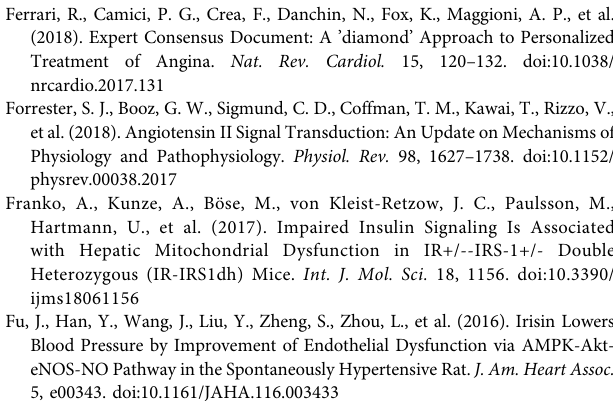
Supplementary Table S1 | Primer sequences for quantitative real-time PCR. Supplementary Table S2 | Key resource